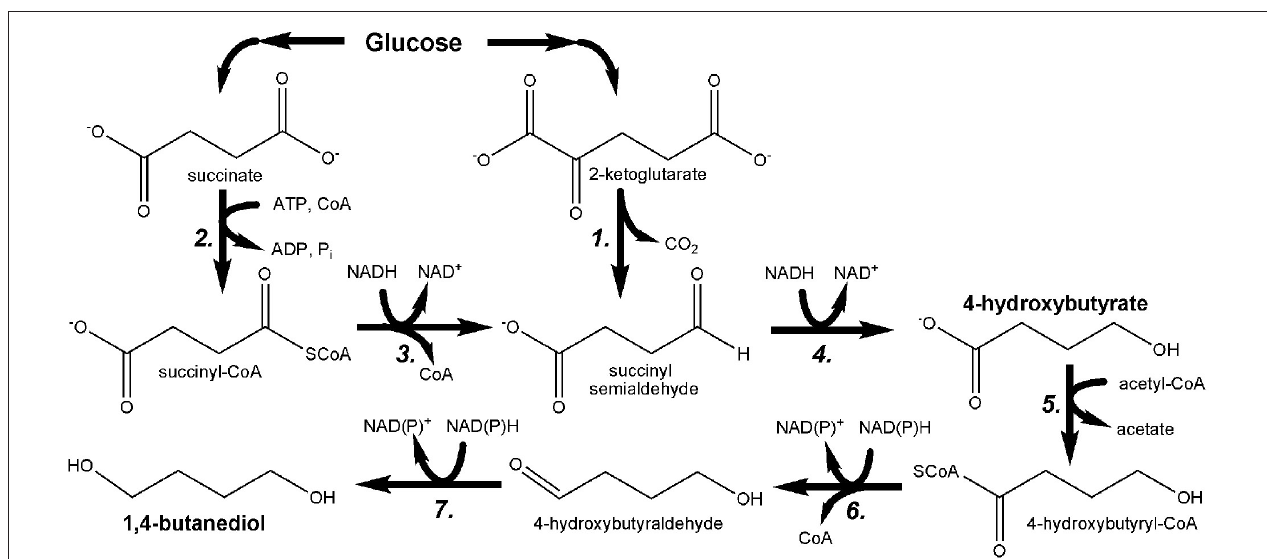
FIGURE 7 | Pathwayengineeredby Yim et al. for the microbial production of 1,4-butanediol (1,4-BDO) through the hydroxyacid intermediate 4-hydroxybutyrate (4HB). 1 . 2-oxoglutarate decarboxylase; 2 . succinyl-CoA